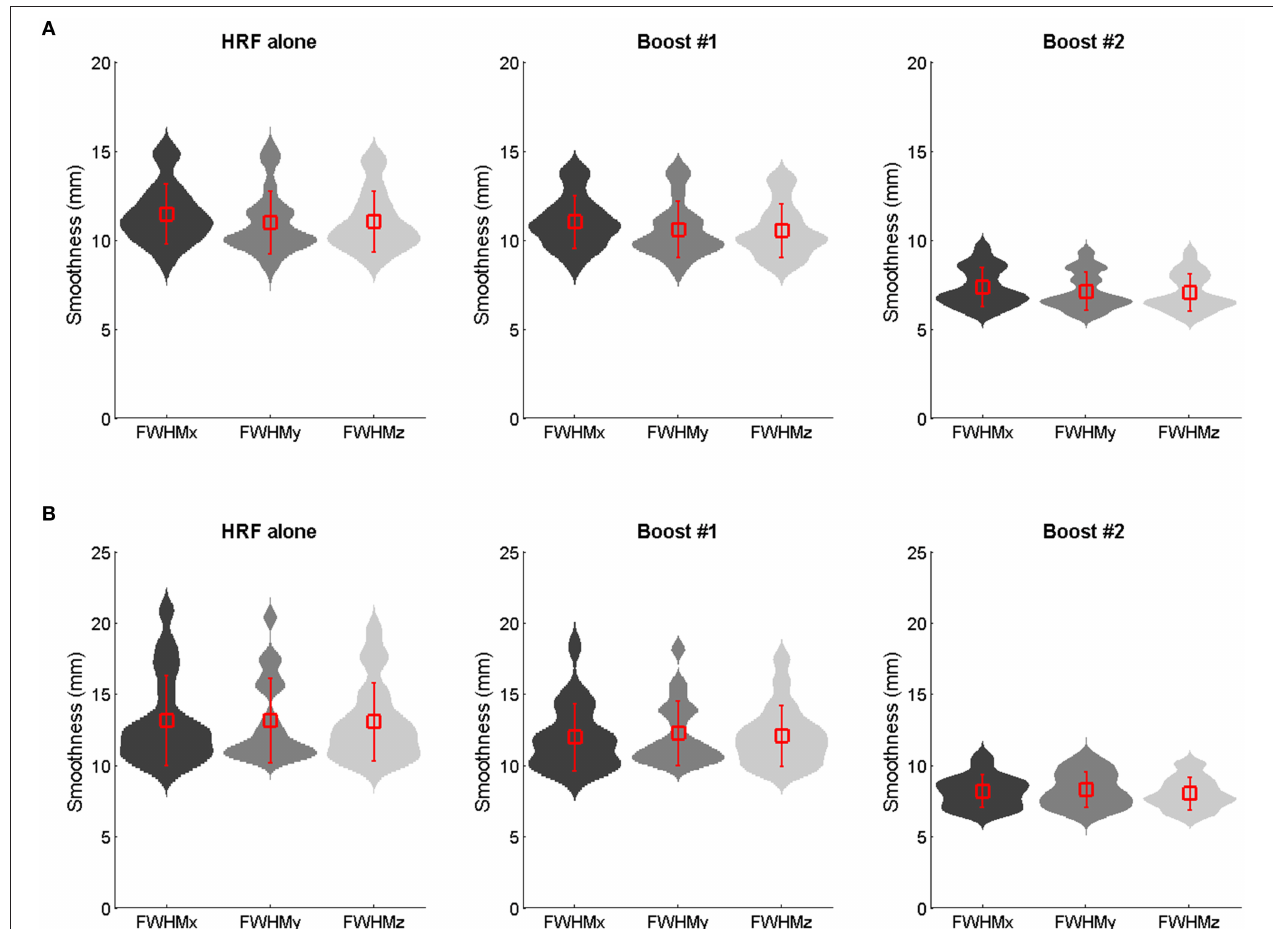
FIGURE 6 | Group mean ± SD smoothness estimates (mm full width at half maximum) of the 100 Hz contrast images as obtained using the HRF only, the constrained boost (boost #1) and the unconstrained boost (boost #2) in adults (A) and children (B). The violin plots show the probability density (using kernel density estimation). Reductions in smoothness occurred for boosted data, especially those boosted by means of the unconstrained basis